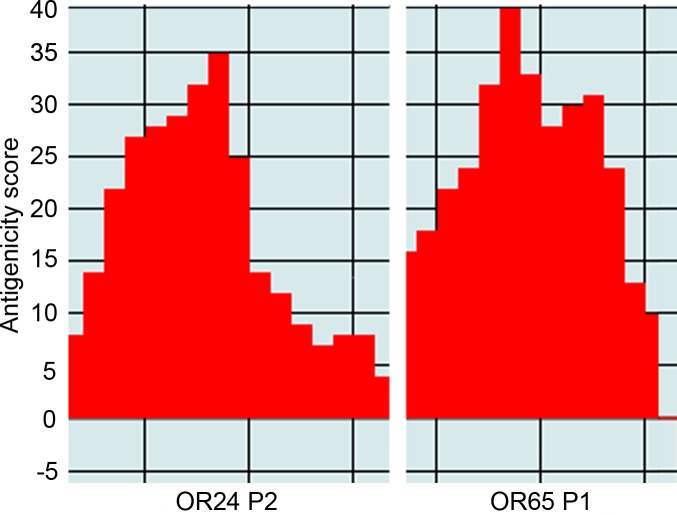
Computer-predicted antigenicity scores for two peptides.One peptide with the highest antigenicity score (calculated by EpiQuest-B) is displayed for each of the two proteins. Polymorphic sequences of OR24 P2 and OR65 P1 show regions of high antigenicity in red. Each red column represents one amino acid from the peptide sequence.